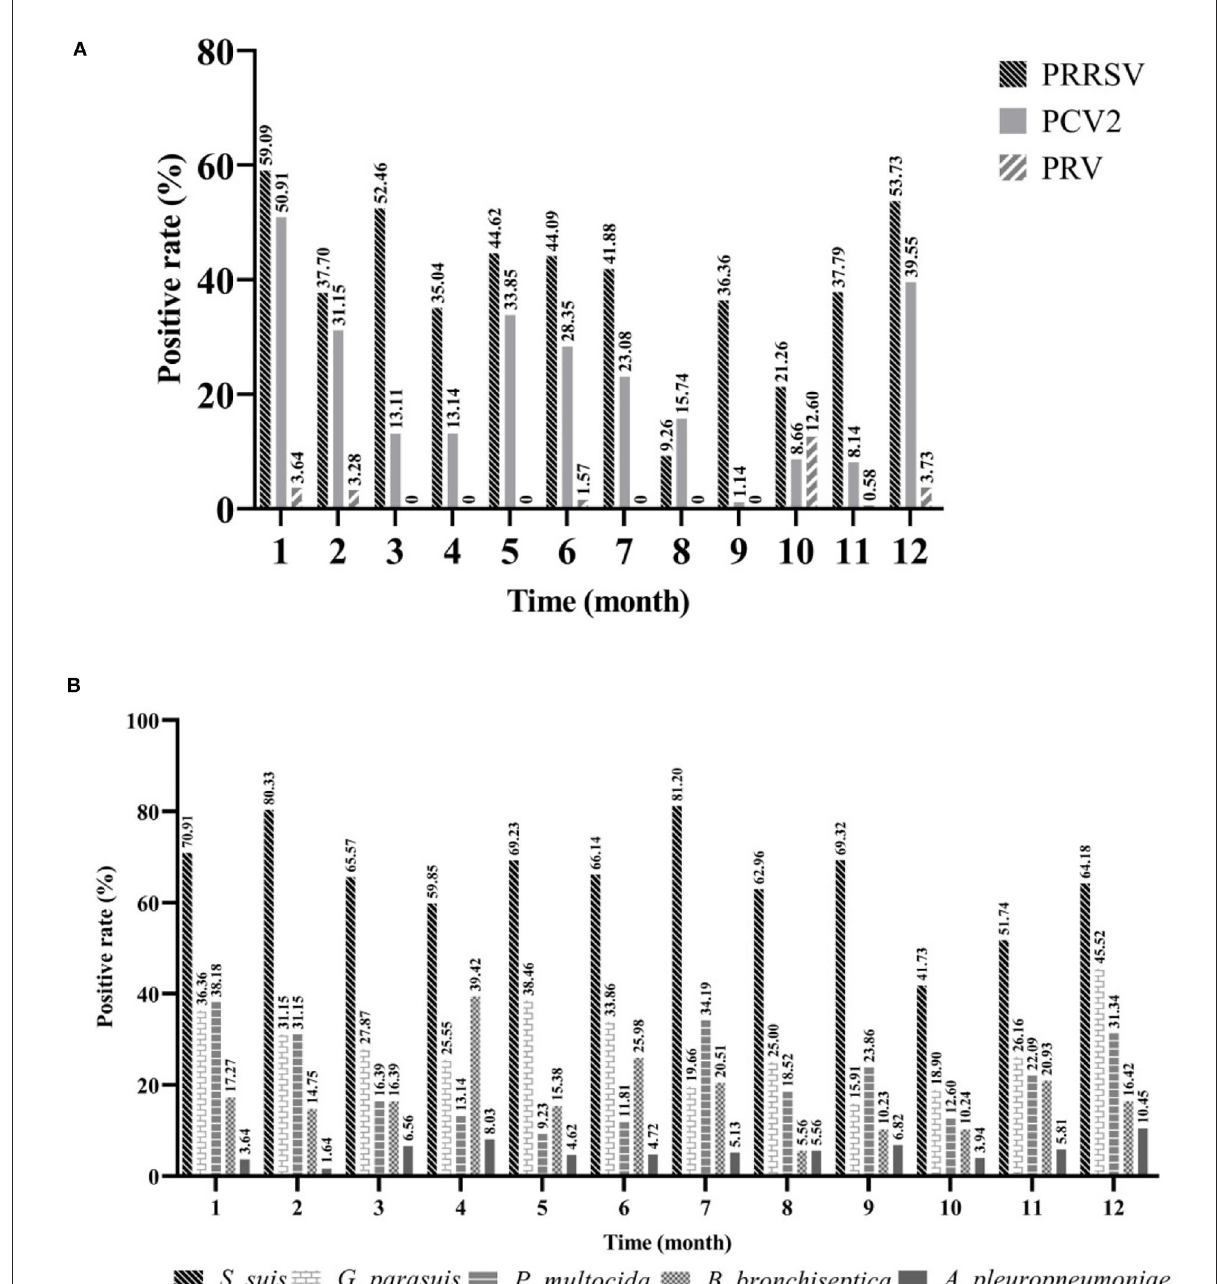
FIGURE4 The seasonal prevalence characteristics of major pathogens. Viruses (A) and bacteria (B) . Jan ( n = 110), Feb ( n = 61), Mar ( n = 61), Apr ( n = 137), May ( n = 65), Jun ( n = 127), Jul ( n = 117), Aug ( n = 108), Sep ( n = 88), Oct ( n = 127), Nov ( n = 172), Dec ( n = 134).